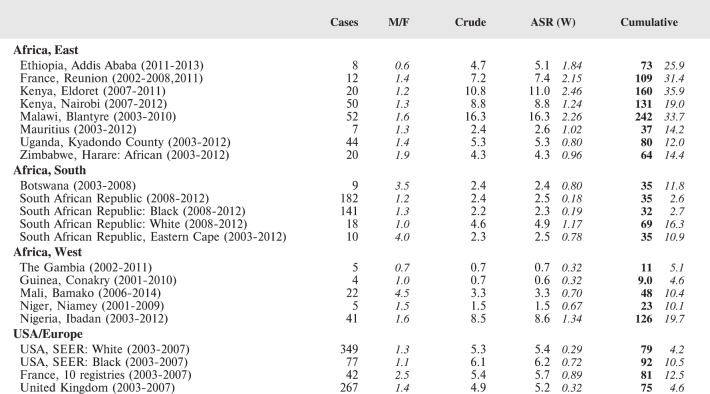
Crude, age-standardised (world) and cumulative (0–14) incidence rates (per million) and standard errors—rhabdomyosarcoma.